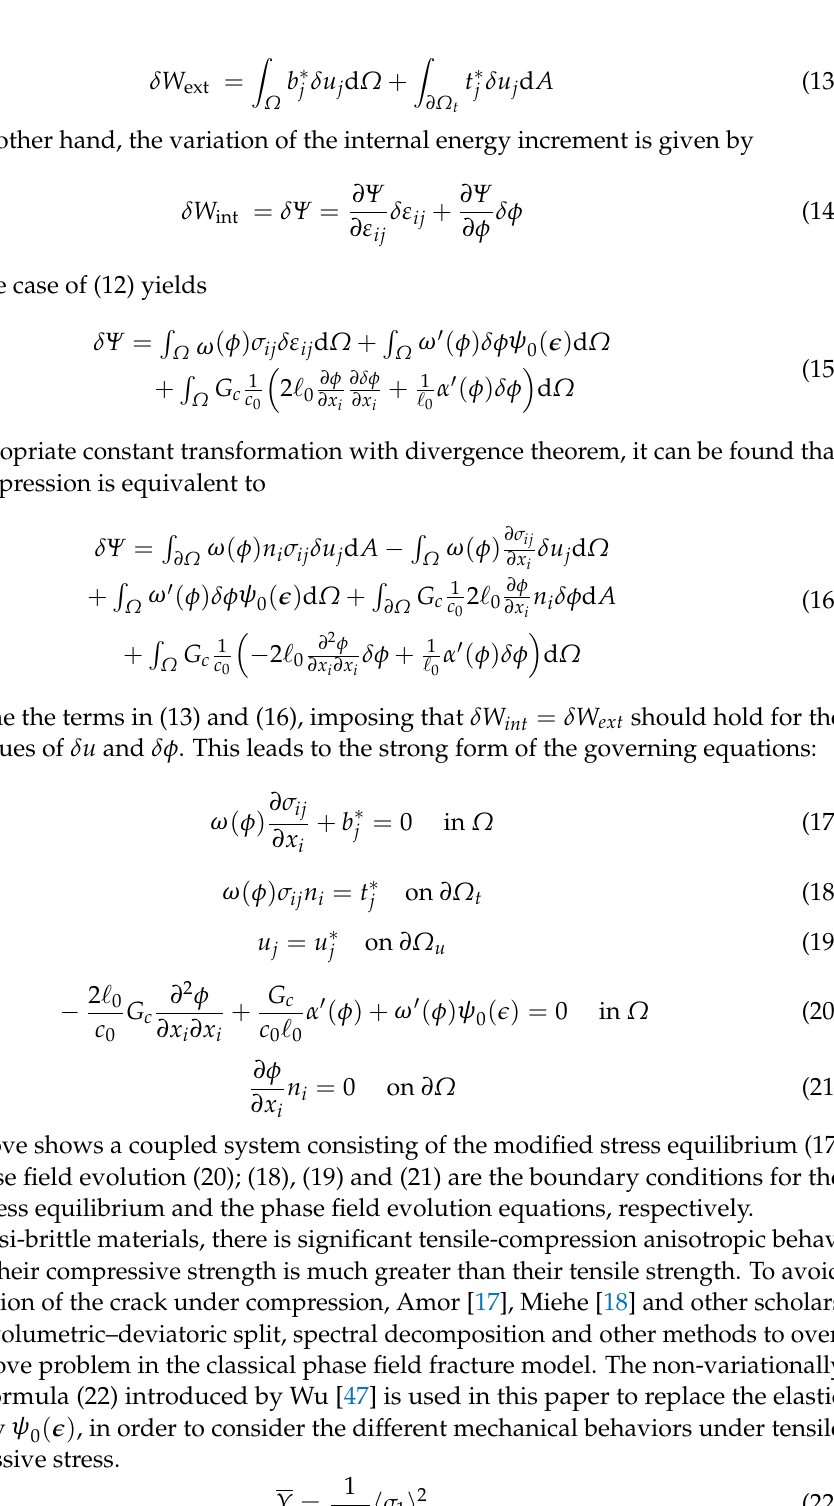
Figure 2. Schematic illustration of sharp ( 𝛤 , left) and diffusive ( ℬ , right) crack topology in a 2D solid 𝛺 with its external boundary ∂𝛺 . The external boundary ∂𝛺 can be divided into two parts: ∂𝛺 (cid:3047) and ∂𝛺 (cid:3048) , with ∂𝛺 (cid:3047) ∩ ∂𝛺 (cid:3048) = ∅ and ∂𝛺 (cid:3047) ∪ ∂𝛺 (cid:3048) = ∂𝛺 , in which it is given displacements 𝒖 ∗ for